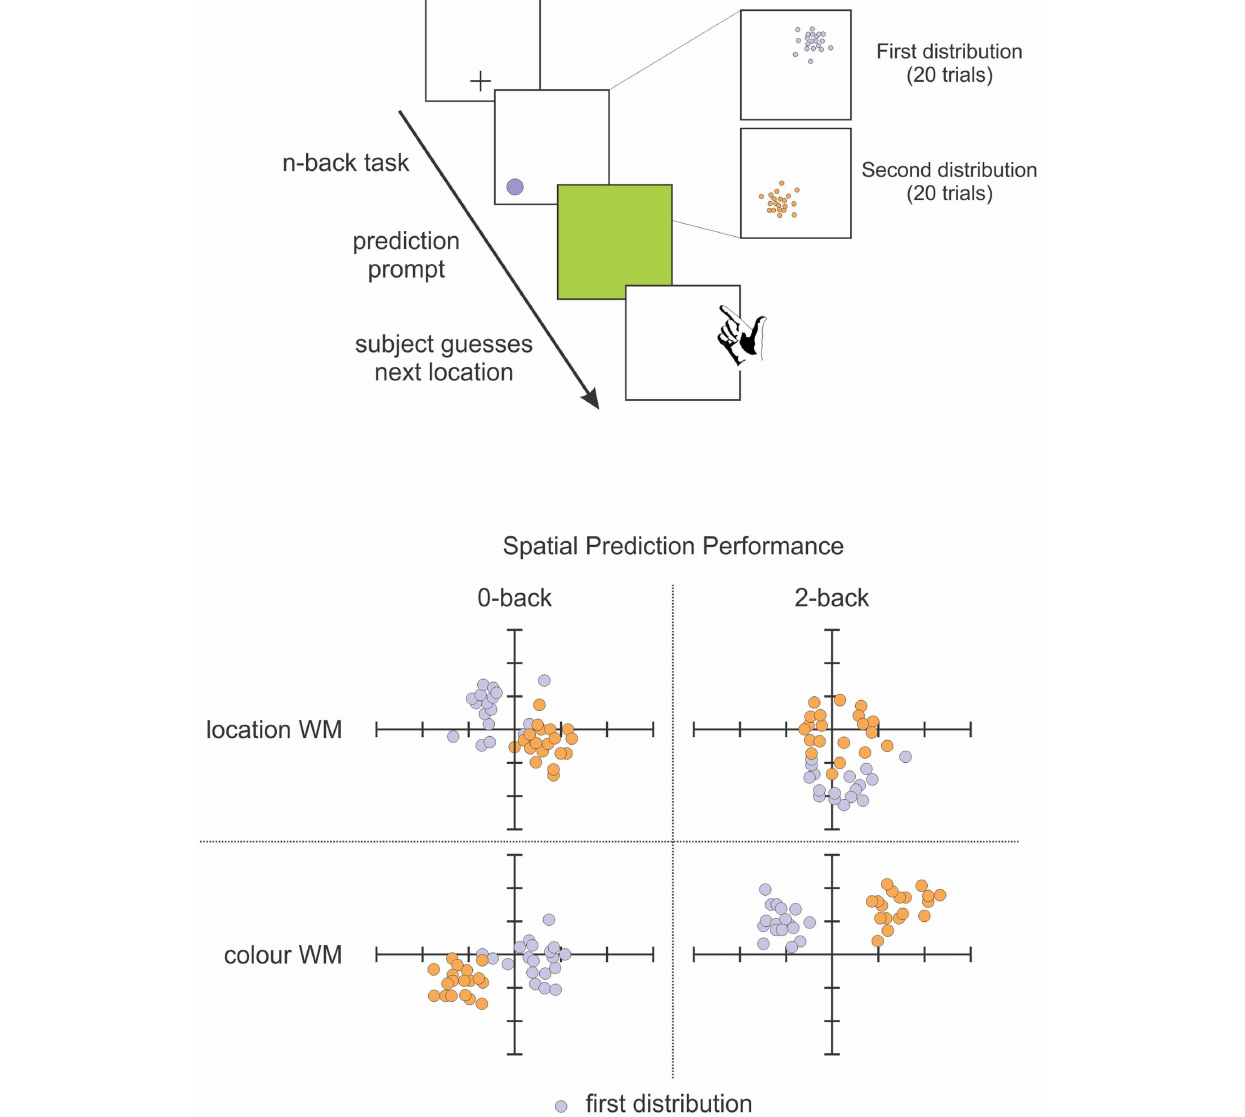
FIGURE 4 | Schematic representation of our spatial prediction and working memory task (Valadao et al., 2012) . Participants first perform an n-back task related to the color or location of targets on a given trial.They are then required to predict the location of a target on the next trial.The distribution for target locations is chosen from 1 quadrant for 20 trials before